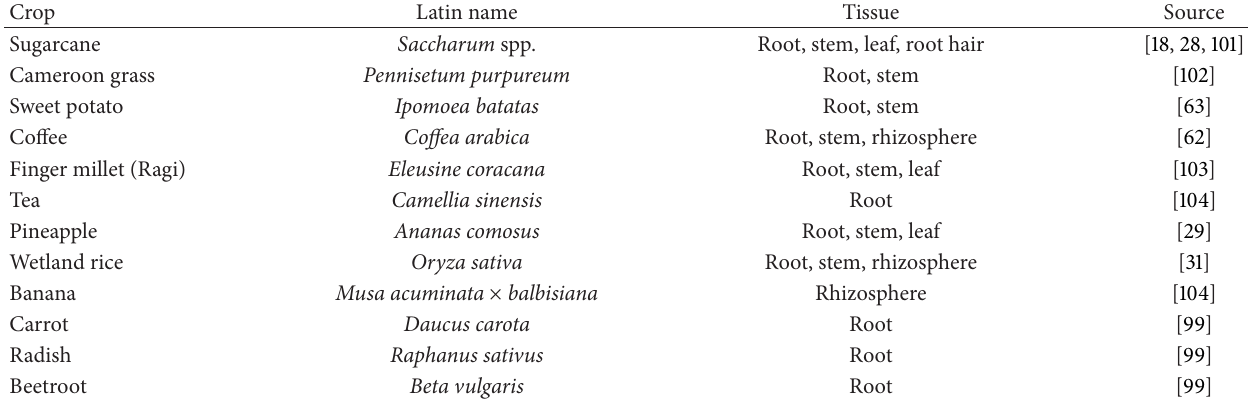
Table 1: Native host plants of Gluconacetobacter diazotrophicus and the tissues from which they were